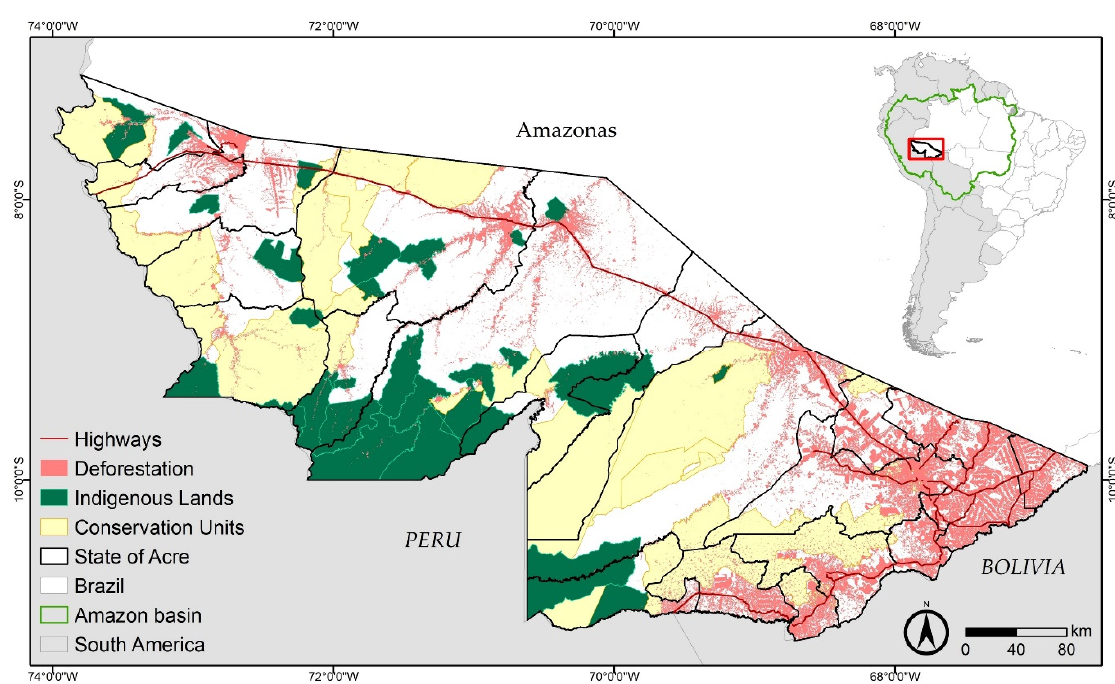
Figure 1. Study area with indigenous lands, conservation units, and deforestation areas in the State of Acre, Brazil in 2019.